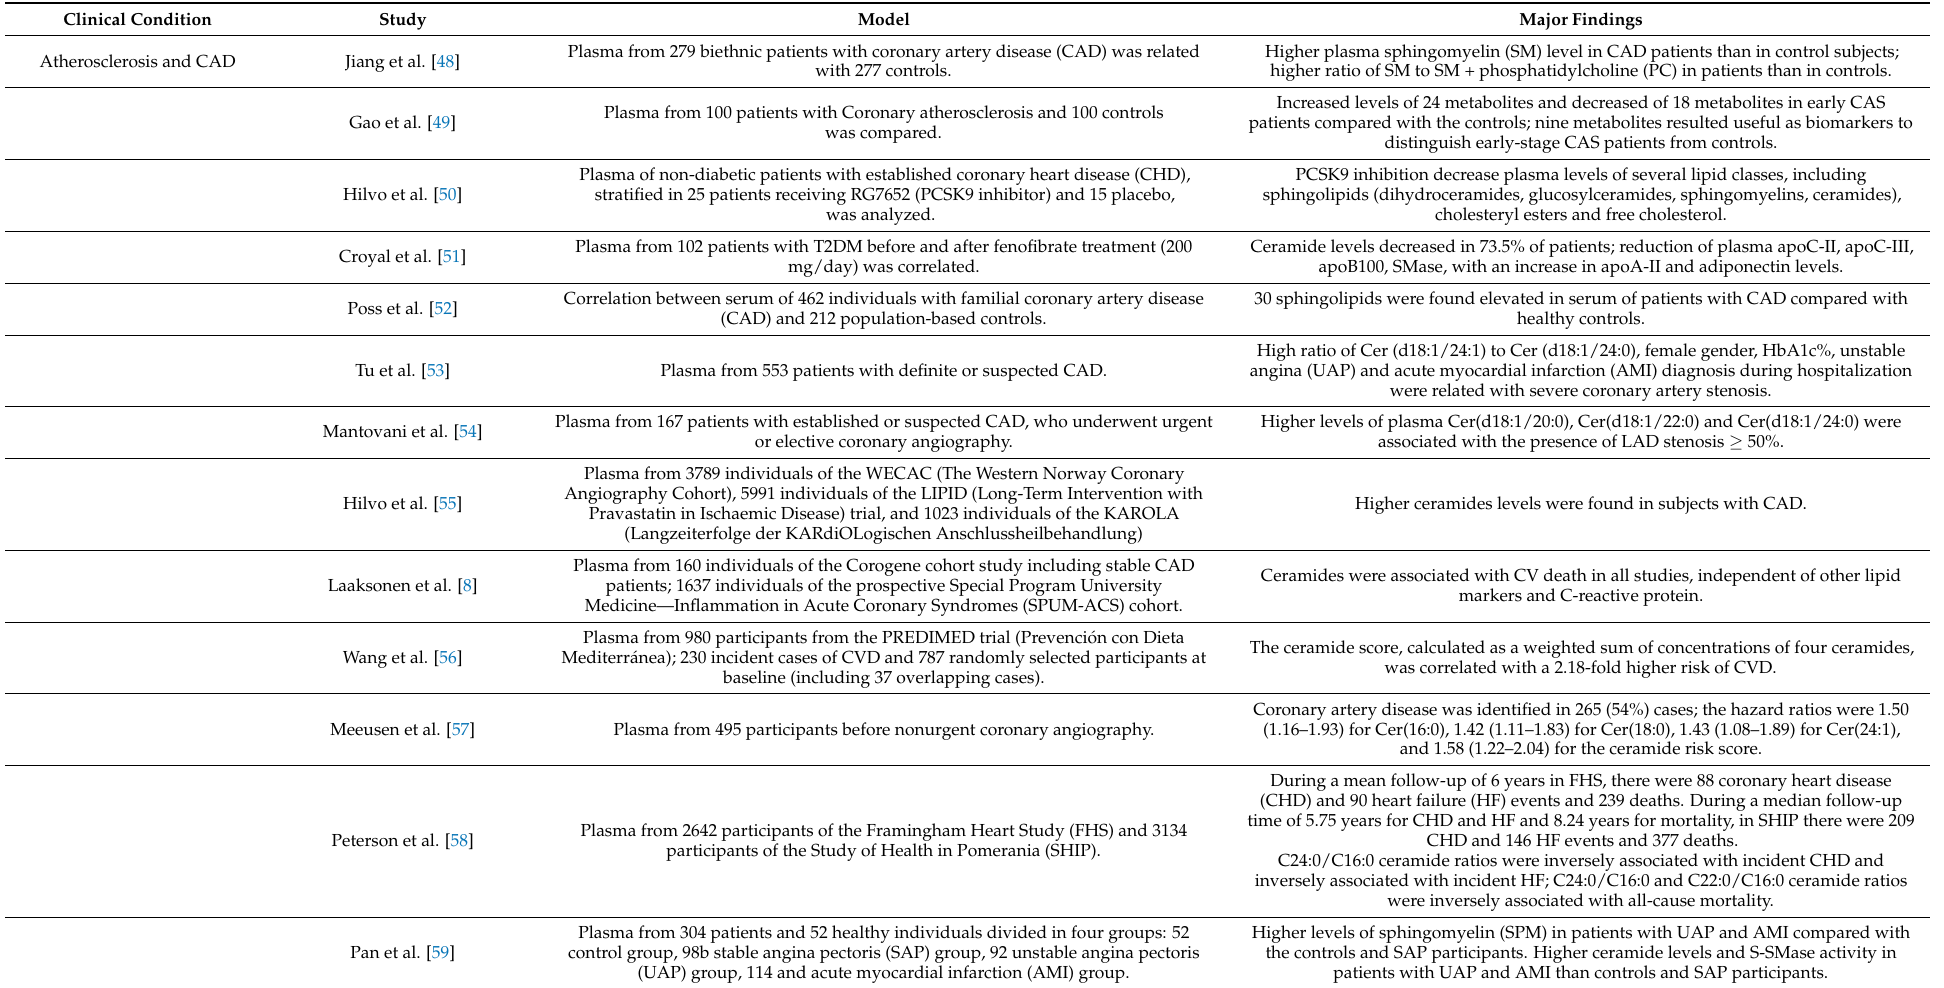
Table 1. Summary of the main findings from the clinical studies discussed in the